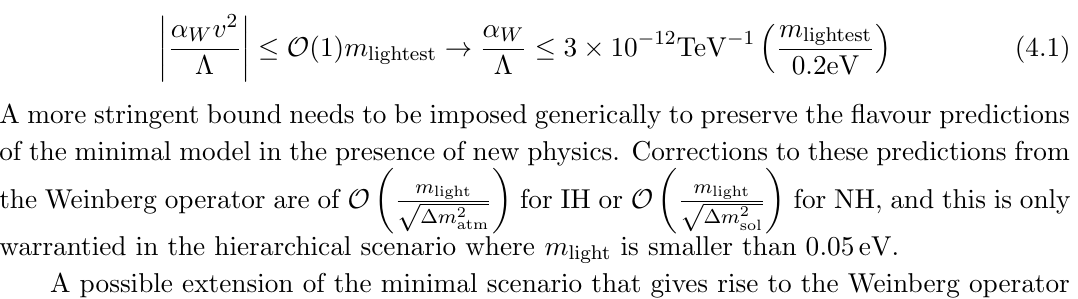
Figure 10 . Expected limits at LHC (13 TeV, 300 fb (cid:0) 1 ) on the BR ( H function of M H c(cid:28) in meters. The mass is 20 GeV and the CP phase (cid:30) 1 = 2 M (red) for NH (solid) and IH